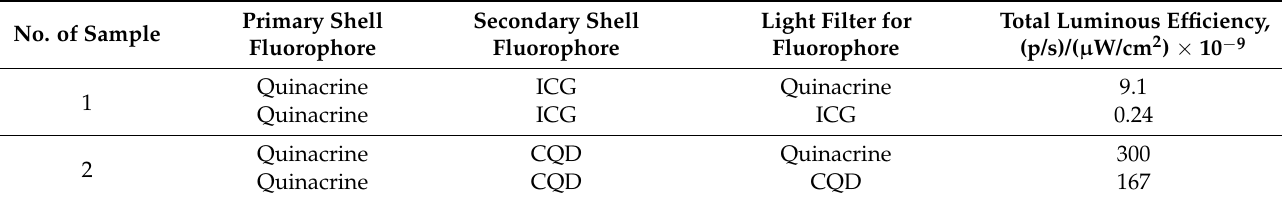
Table 6. Measured values of luminous efficiency of fluorescent radiation of the SNP-GPMS-quinacrine- chitosan-ICG (CQD)